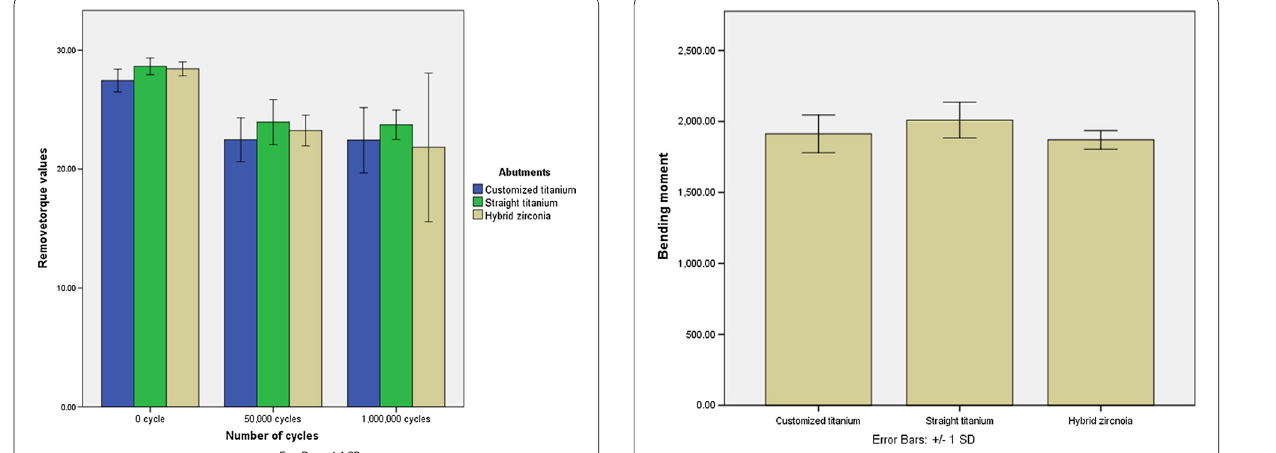
Fig. 5 Comparison of the mean of bending moment between abutment types. No statistically significant difference found ( P -value >